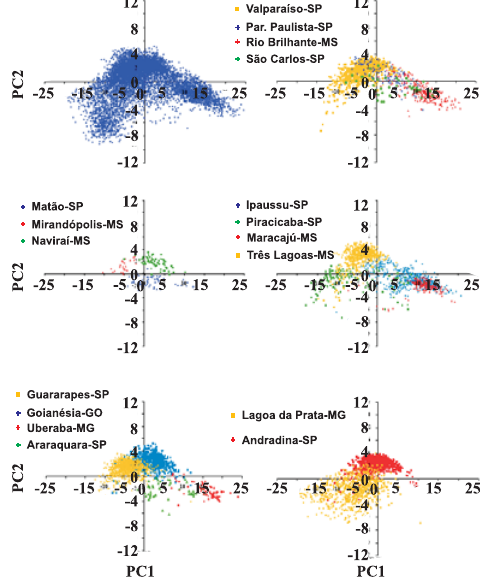
Figure 4. Spectral curves from soil profiles: Cambissolos, Neossolos Litólicos and Neossolos .Quartzarênicos, representing the Soil Spectral